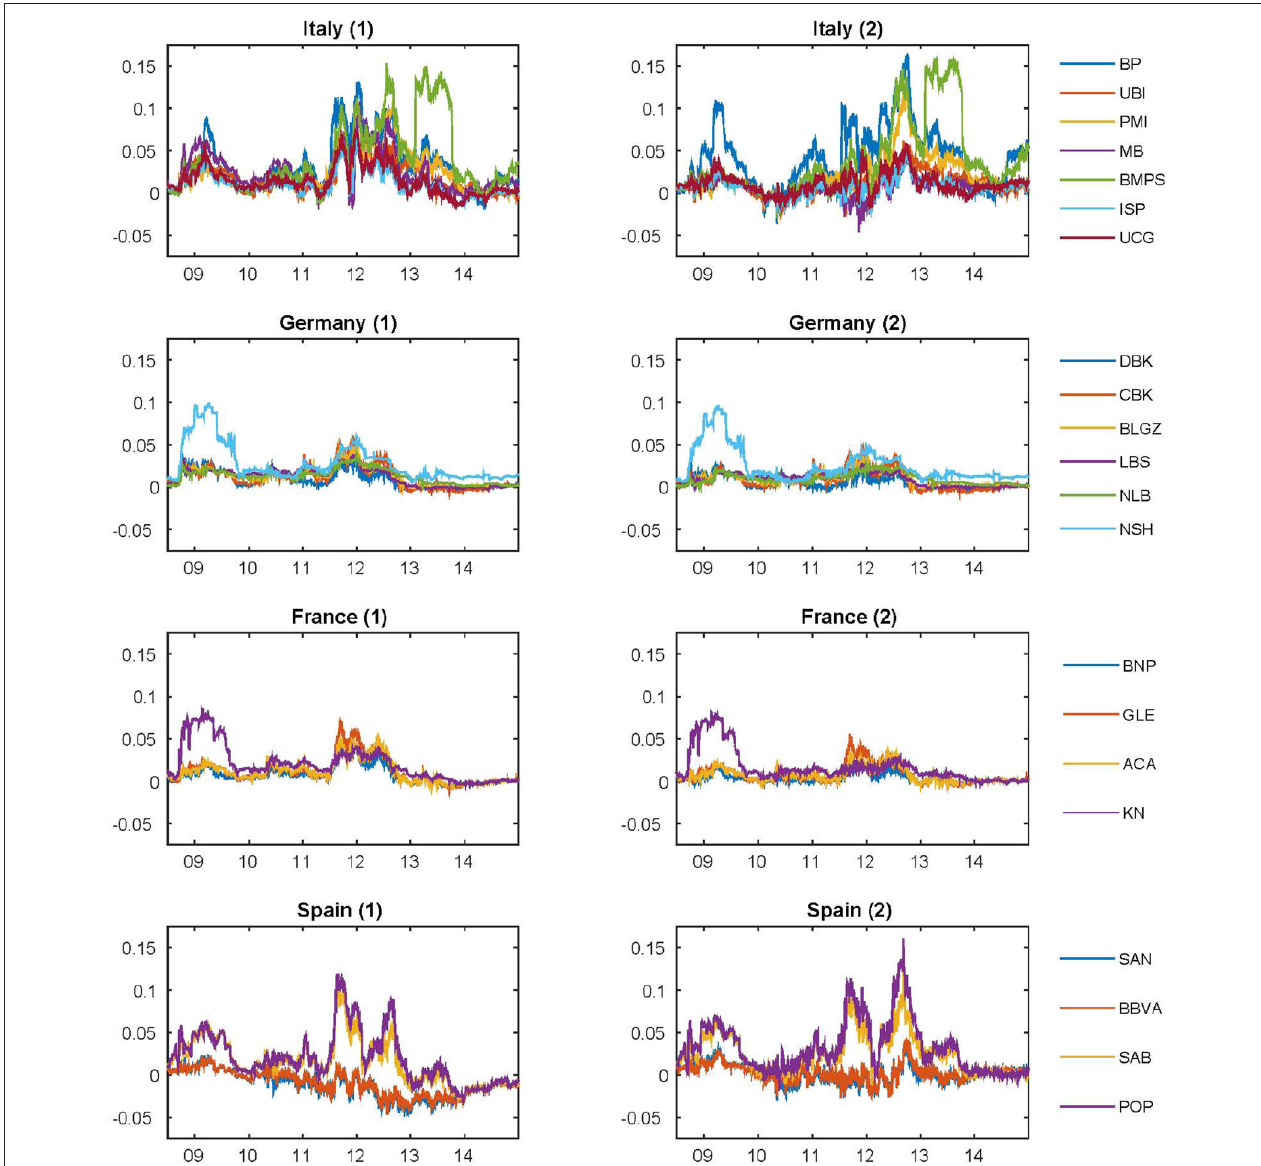
FIGURE 5 | Default intensity processes based the multi-factor model with Vasicek dynamics for the 14 banks from June 30, 2008 to December 31, 2014. The Kalman filter is considered to extract the unobservable default intensity processes ξ t (1) and γ t (2). While in (1) we report the estimation of the factor driving the spread between bank CDS and the sovereign bond yield, in (2) we report the estimation of the factor driving the difference between bank and sovereign CDS quotes. We consider the risk-free rate Eonia as discount factor.